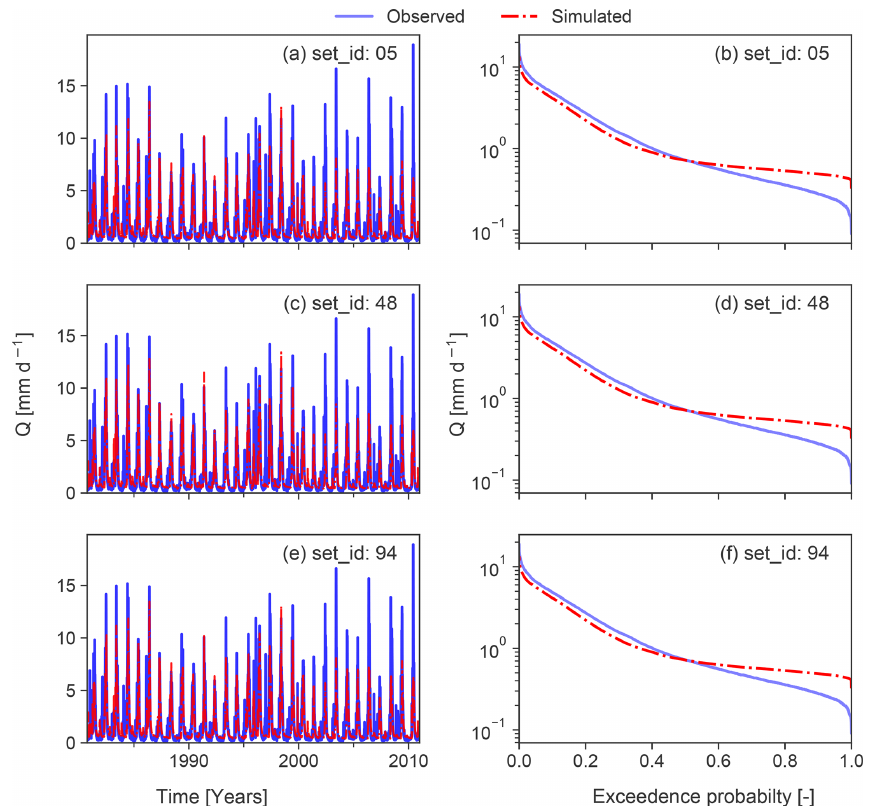
Figure 4. Simulated and observed streamflow time series of modelling examples for the year 2000 (a, c, e) and the related flow duration curves for the entire time series (b, d, f) . Time series are derived from the CAMELS dataset (Addor et al., 2017). Observations and simulations belong to the same catchment as in Fig. 1. Simulations were produced by model runs with different parameter sets (set_id) but same input data (see Newman et al.,